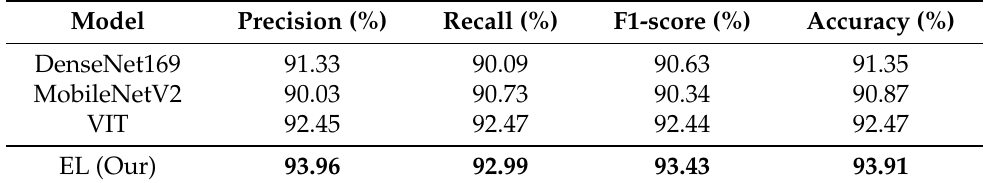
Table 2. Comparison of testing data results among the proposed Ensemble Learning (EL) and three well-known CNN